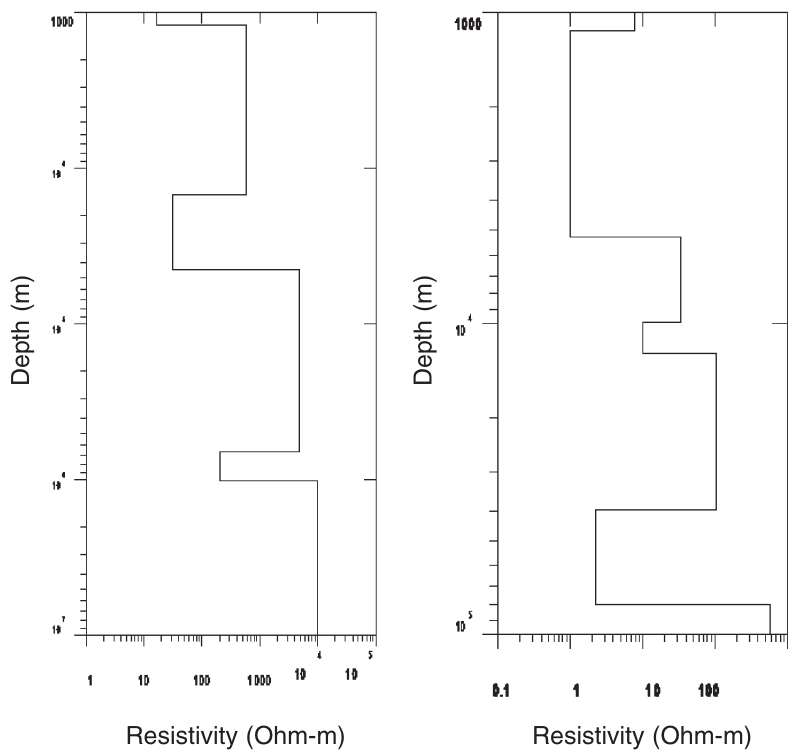
Fig. 2. Apparent resistivity as given by the forward models for GEOSTAR-2 (left) and ORIONGEOSTAR-3 (right)